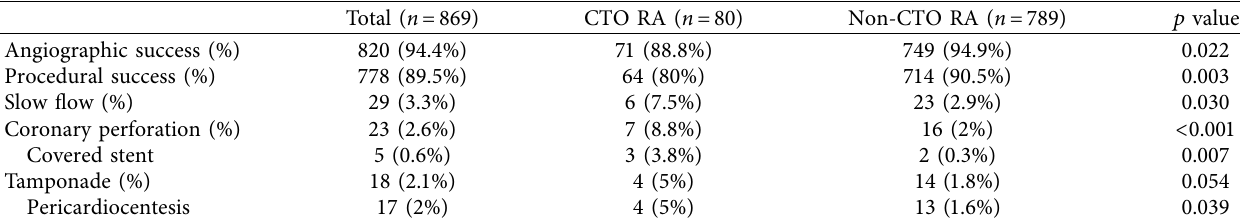
Table 4: Success rate and periprocedural